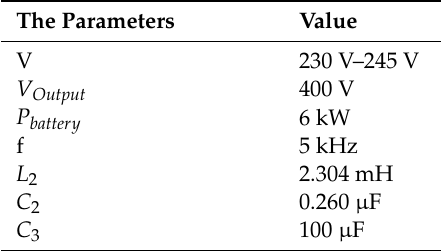
Table 3. DC–DC bidirectional converter parameters.